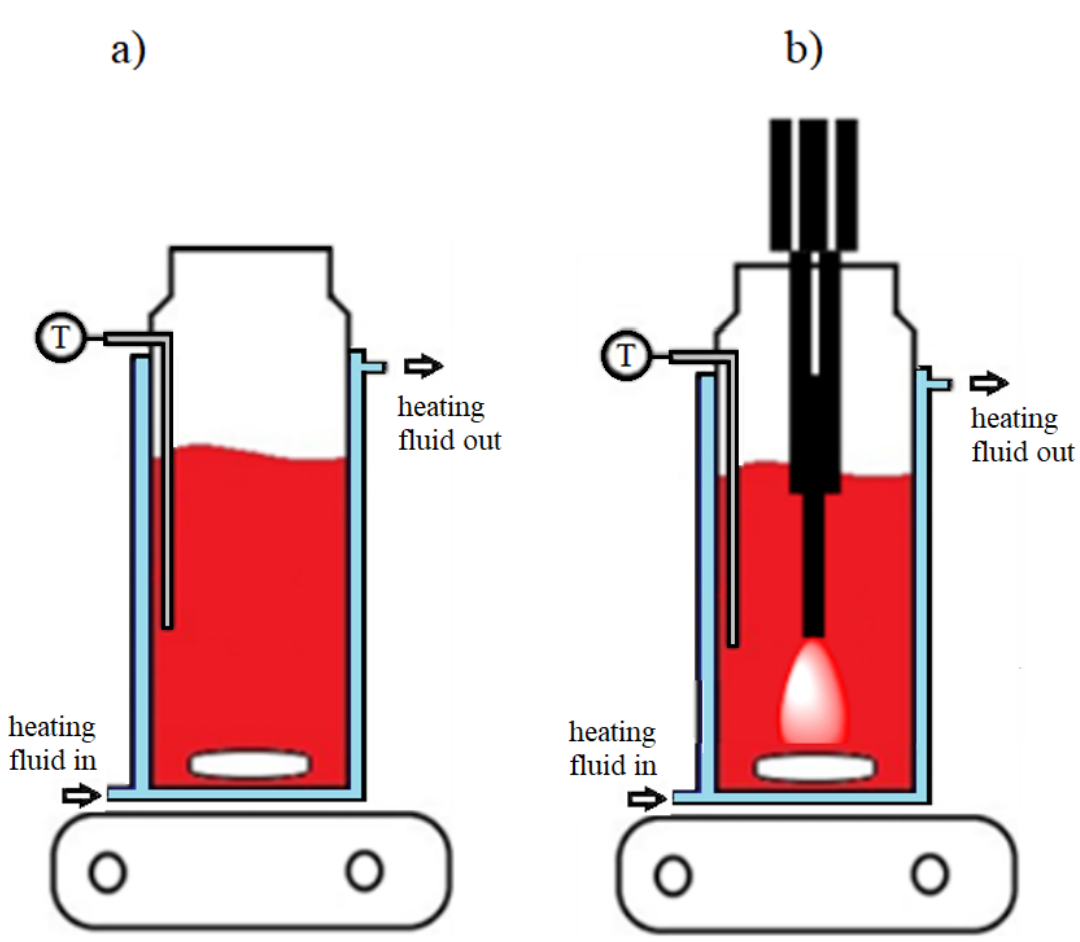
Figure 1. Extraction experiments set-up for ( a ) conventional and ( b ) ultrasound-assisted extractions.